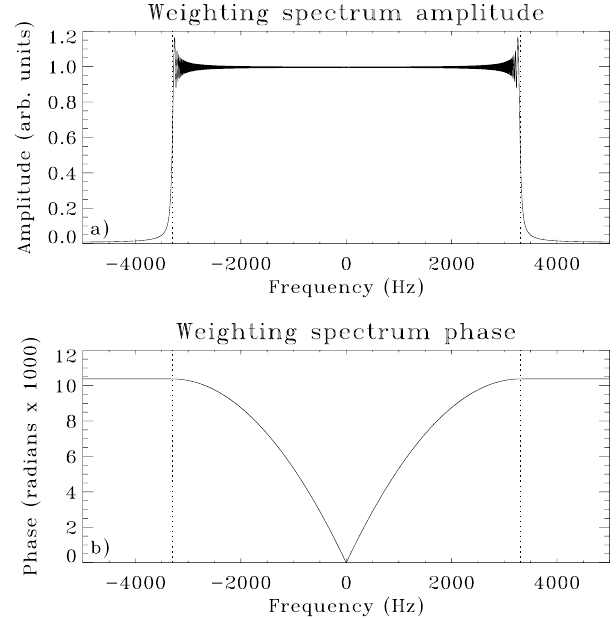
Fig. 1. Weighting spectrum (a) amplitude and (b) phase for simu- lated data generated assuming a 31MHz radar with meteoroid speed of 40kms − 1 , range 150km, sampling time 0.0001s, and time-series duration 2s. The dotted line indicates f max